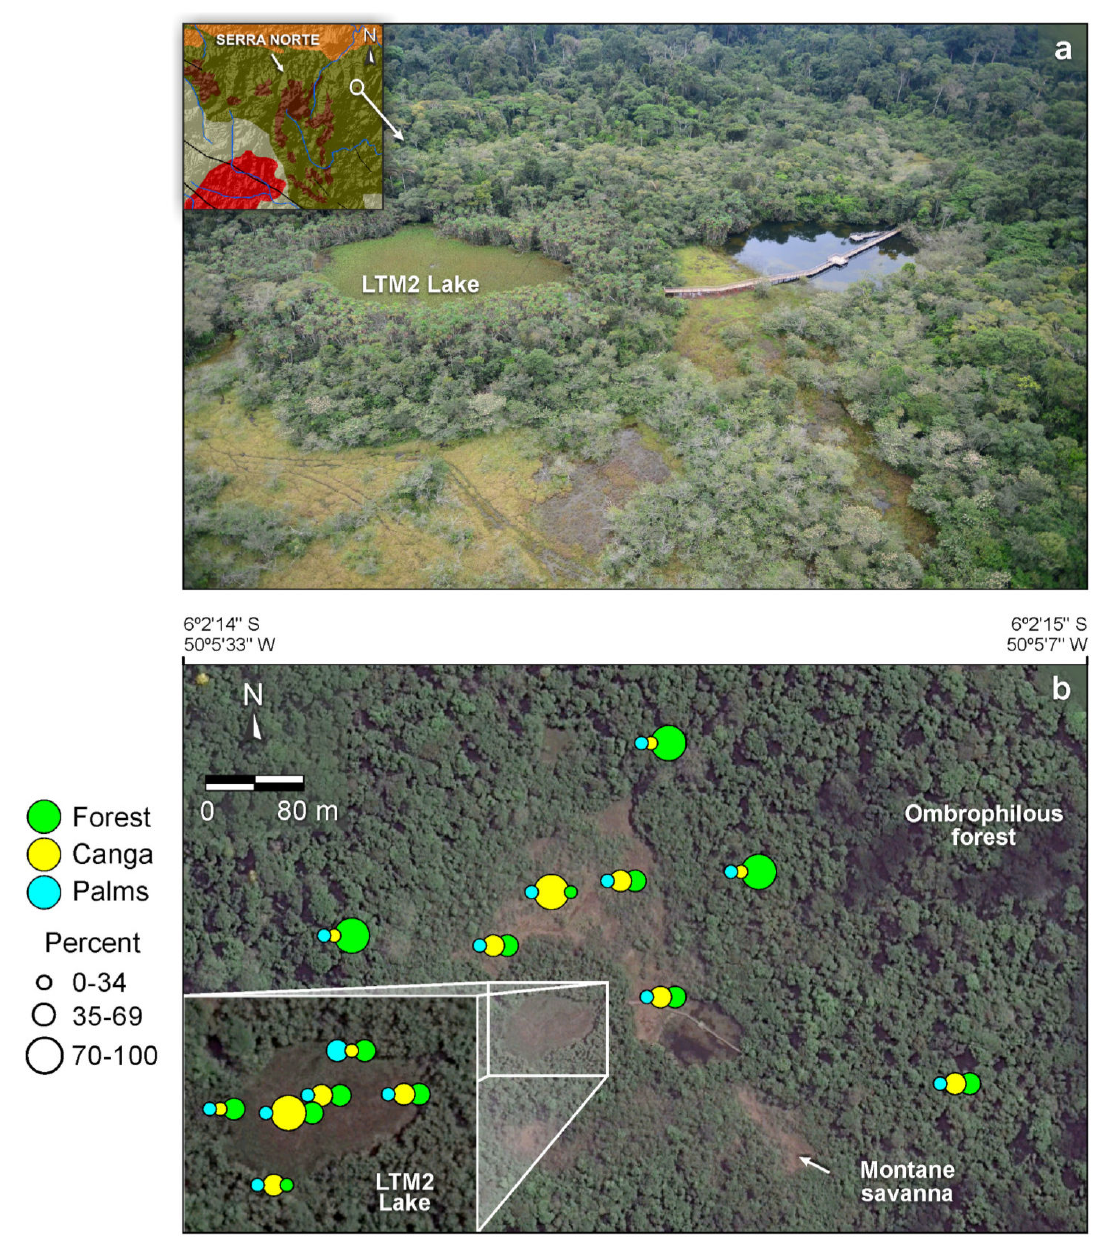
Figure 8. Modern pollen rain of the catchment basin of Lake LTM2 [28], Norte mountain range ( a ), showing the annual contribution (in %) of grains from forest, canga and palms ( b